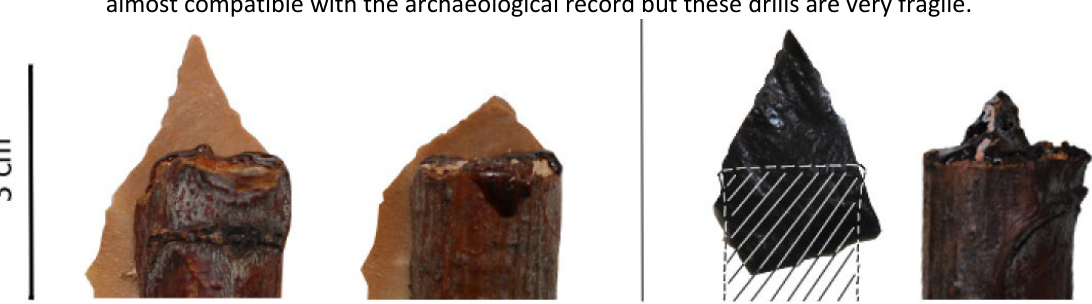
Figure 16: Flint (left) and obsidian (right) drill bits, before and after use. They allowed to produce the beginnings of perforation, but too large compared to the archaeological